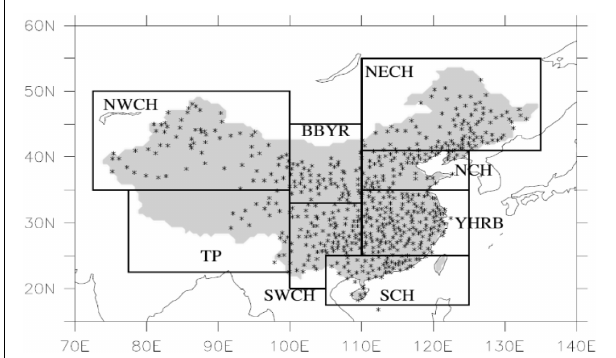
FIGURE 3 | China’s terrestrial climate regional division